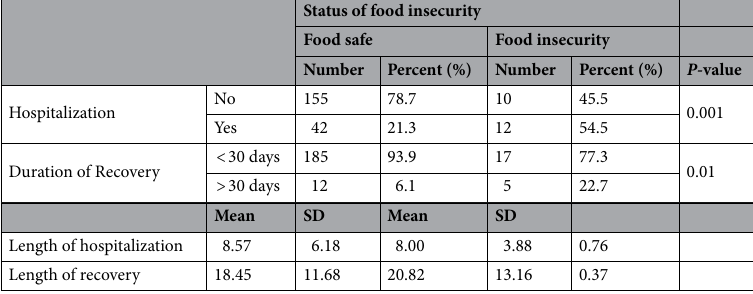
Table 3. Hospitalization and recovery in the study population.